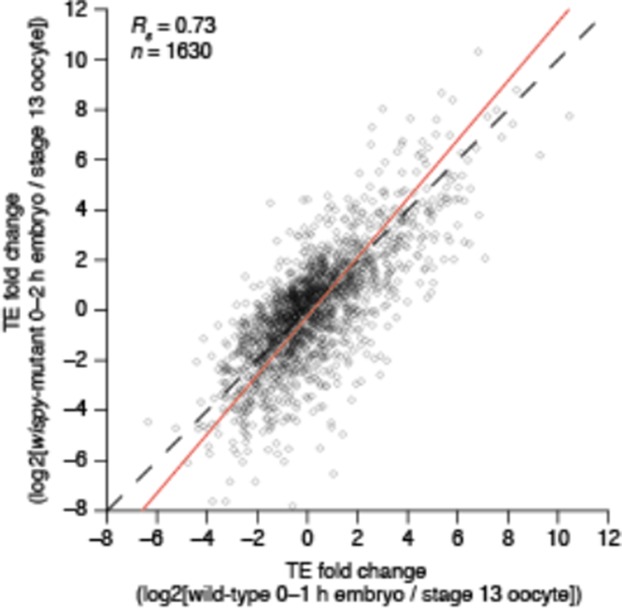
DOI:
http://dx.doi.org/10.7554/eLife.16955.019